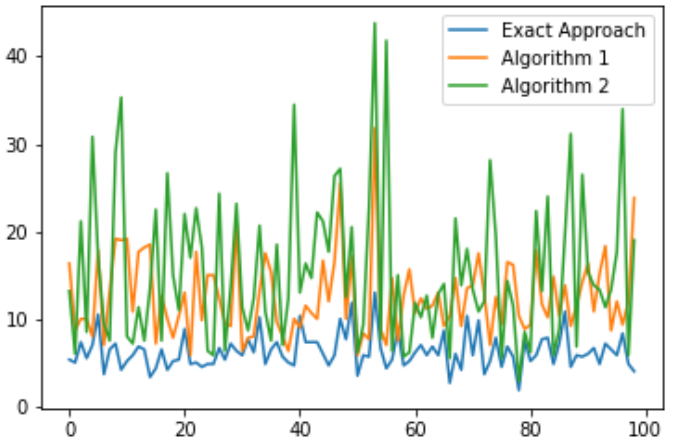
Figure 7. Graph of the dependence of the gap hours on the examples with a large variation of the